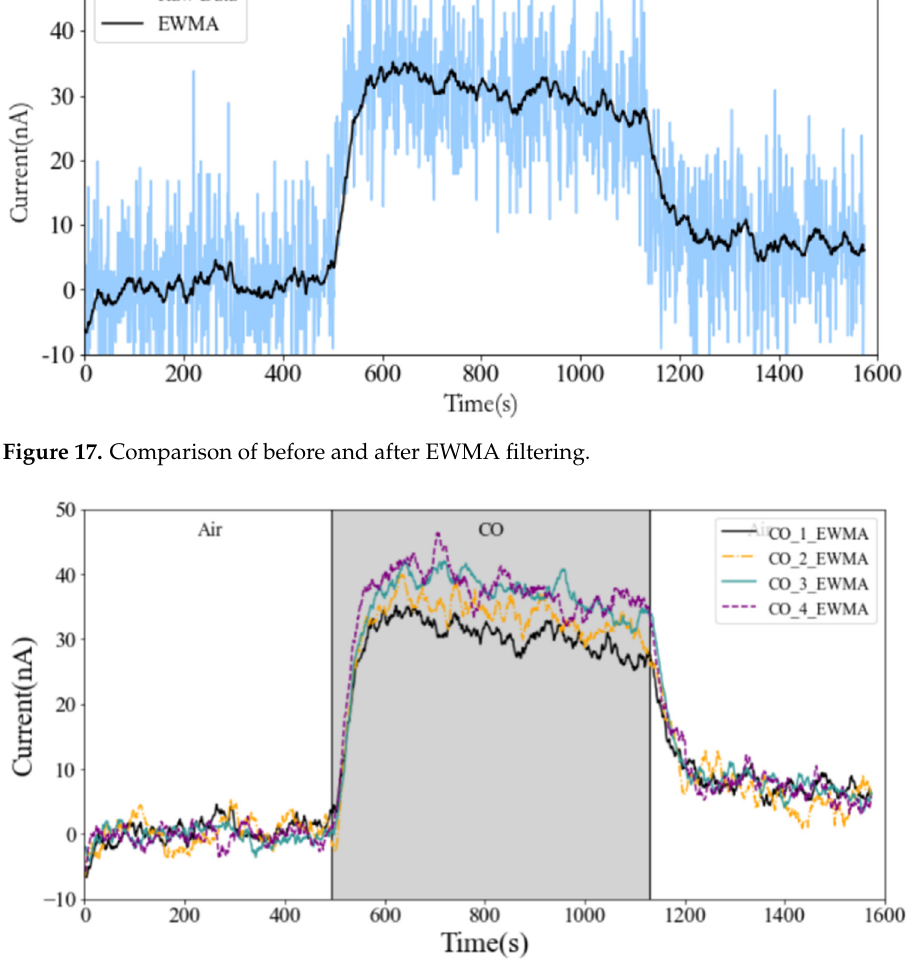
Figure 18. Response results of 4 CO sensors in series cavity.